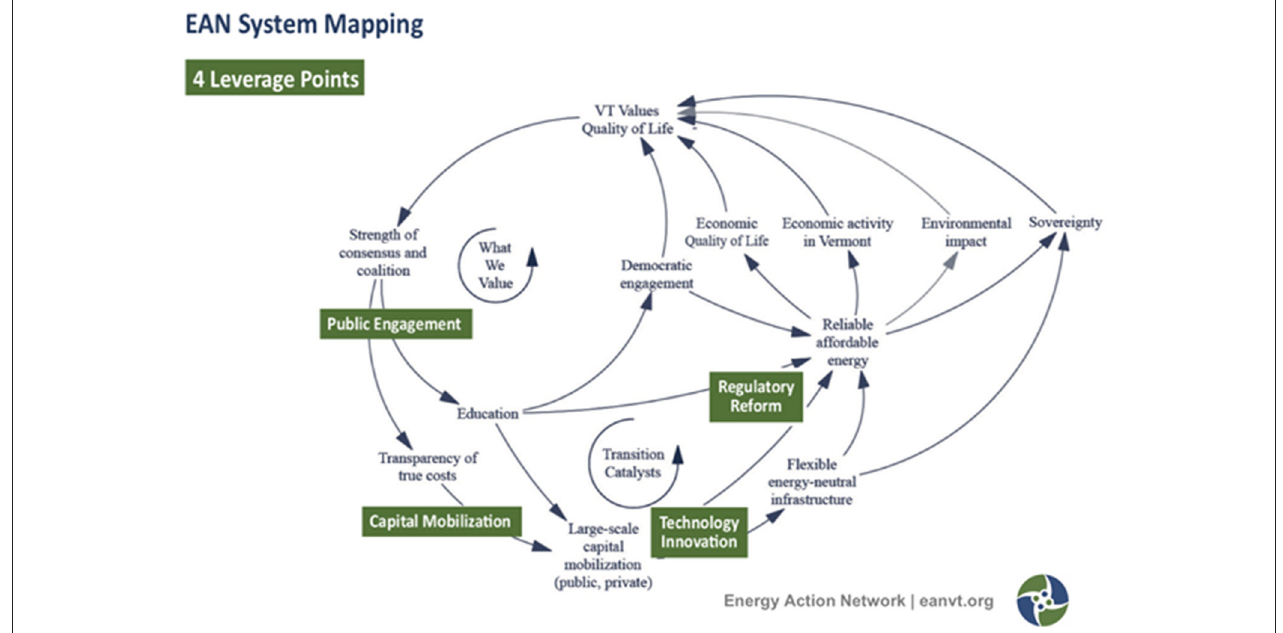
FIGURE 1 | A social system network map of the Vermont energy innovation system created by the Vermont Energy Action Network (EAN, 2016). Reproduced with permission of the Vermont Energy Action